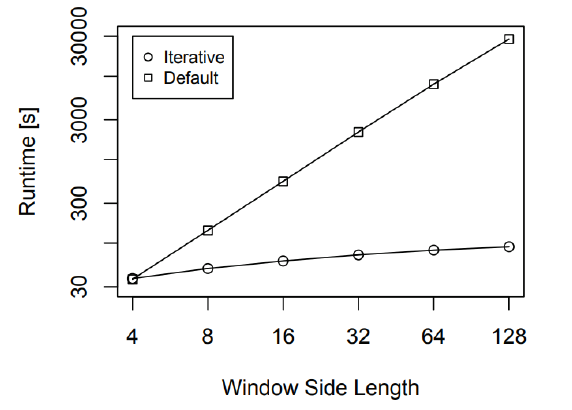
Figure 2. Runtime